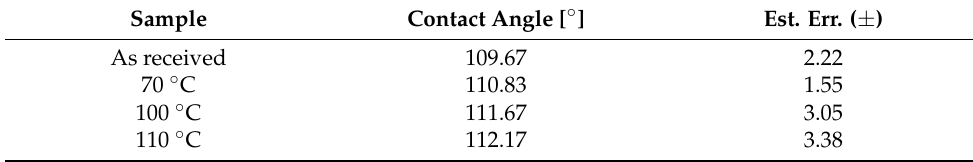
Table 4. The measured contact